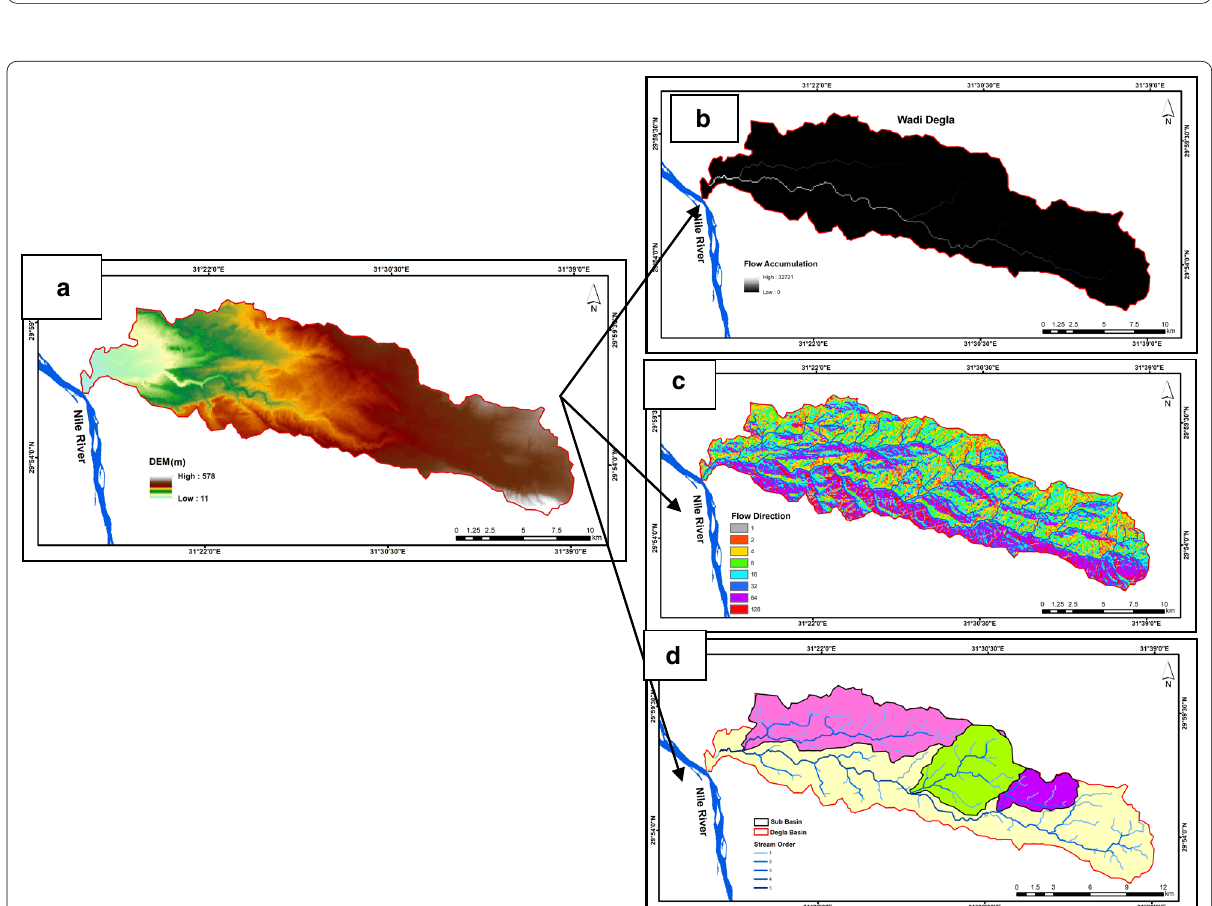
Fig. 12 a Digital elevations model (DEM) of the study area to estimate, b flow accumulations, c flow directions, and d drainage